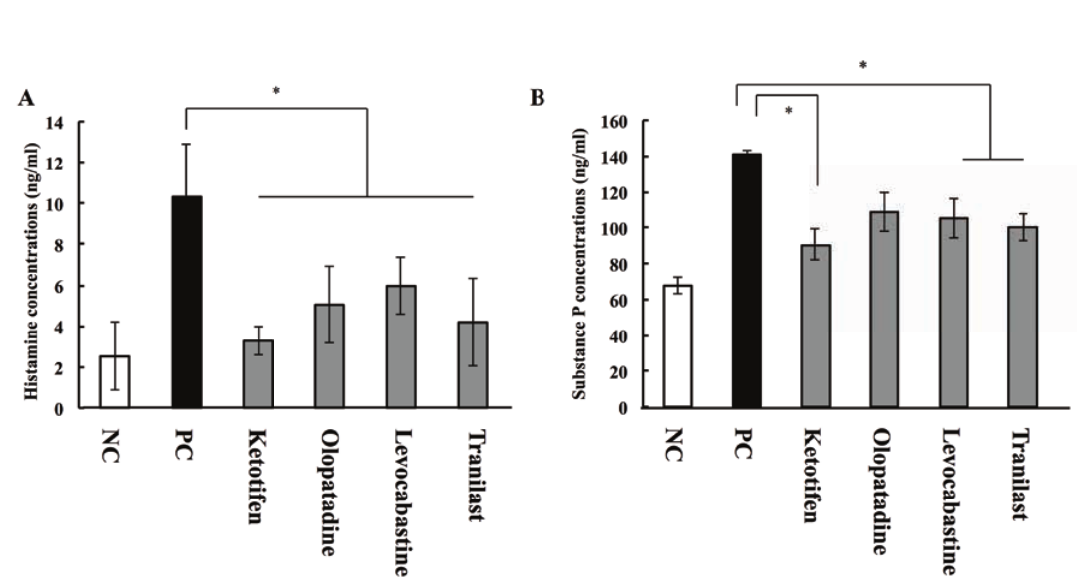
Figure 5: Effects of anti-allergic drugs on histamine and substance P concentrations in tears. On day 19, 15 min after the final challenge, concentrations of (A) histamine and (B) substance P were measured by ELISA. * P < 0.05 vs. posi- tive control group. Data represent means ± S.E.M from three independent experiments (n = 12 per